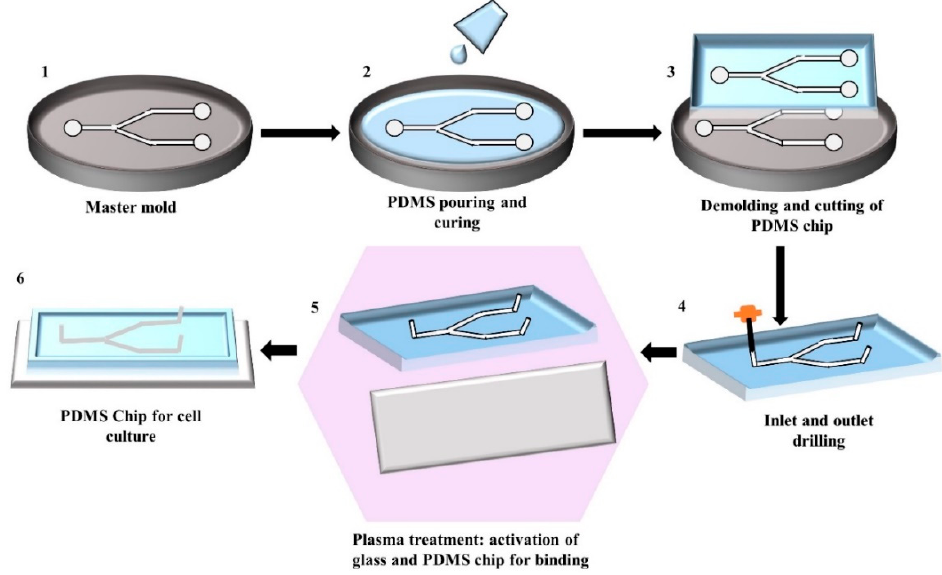
Figure 1. Illustration of the step-by-step fabrication process of a PDMS chip by replica moulding: ( 1 ) Generating silicon master mould using photolithography; ( 2 ) Pouring of the mixture of PDMS prepolymer and curing agent into the master mould and allowing it to solidify; ( 3 ) Peeling of the solidified PDMS from the master mould and cutting it into an appropriate shape; ( 4 ) Punching the inlet and outlet holes; ( 5 ) Activating the PDMS and glass surface by plasma treatment for facilitating the bonding; ( 6 ) Binding and curing of PDMS chip bonded on glass ready to use.